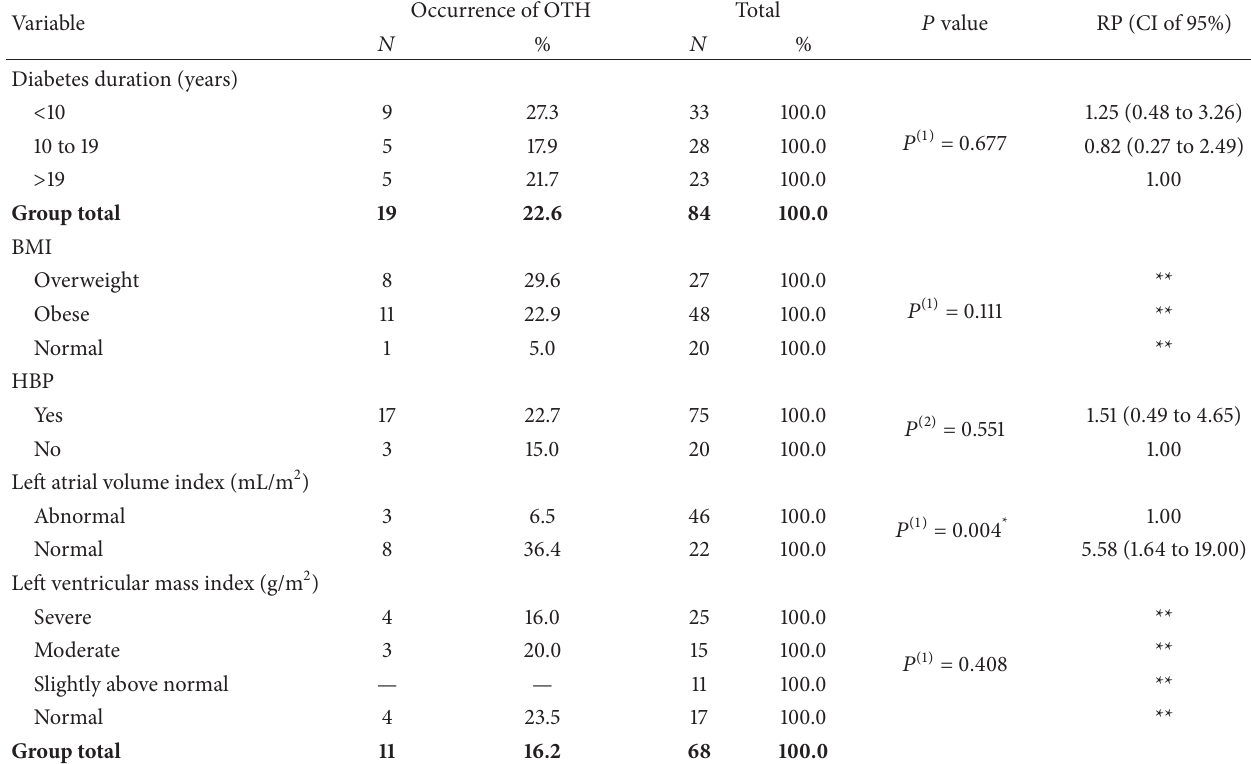
Table 2: Evaluation of the occurrence of orthostatic hypertension (OHT) according to clinical data.